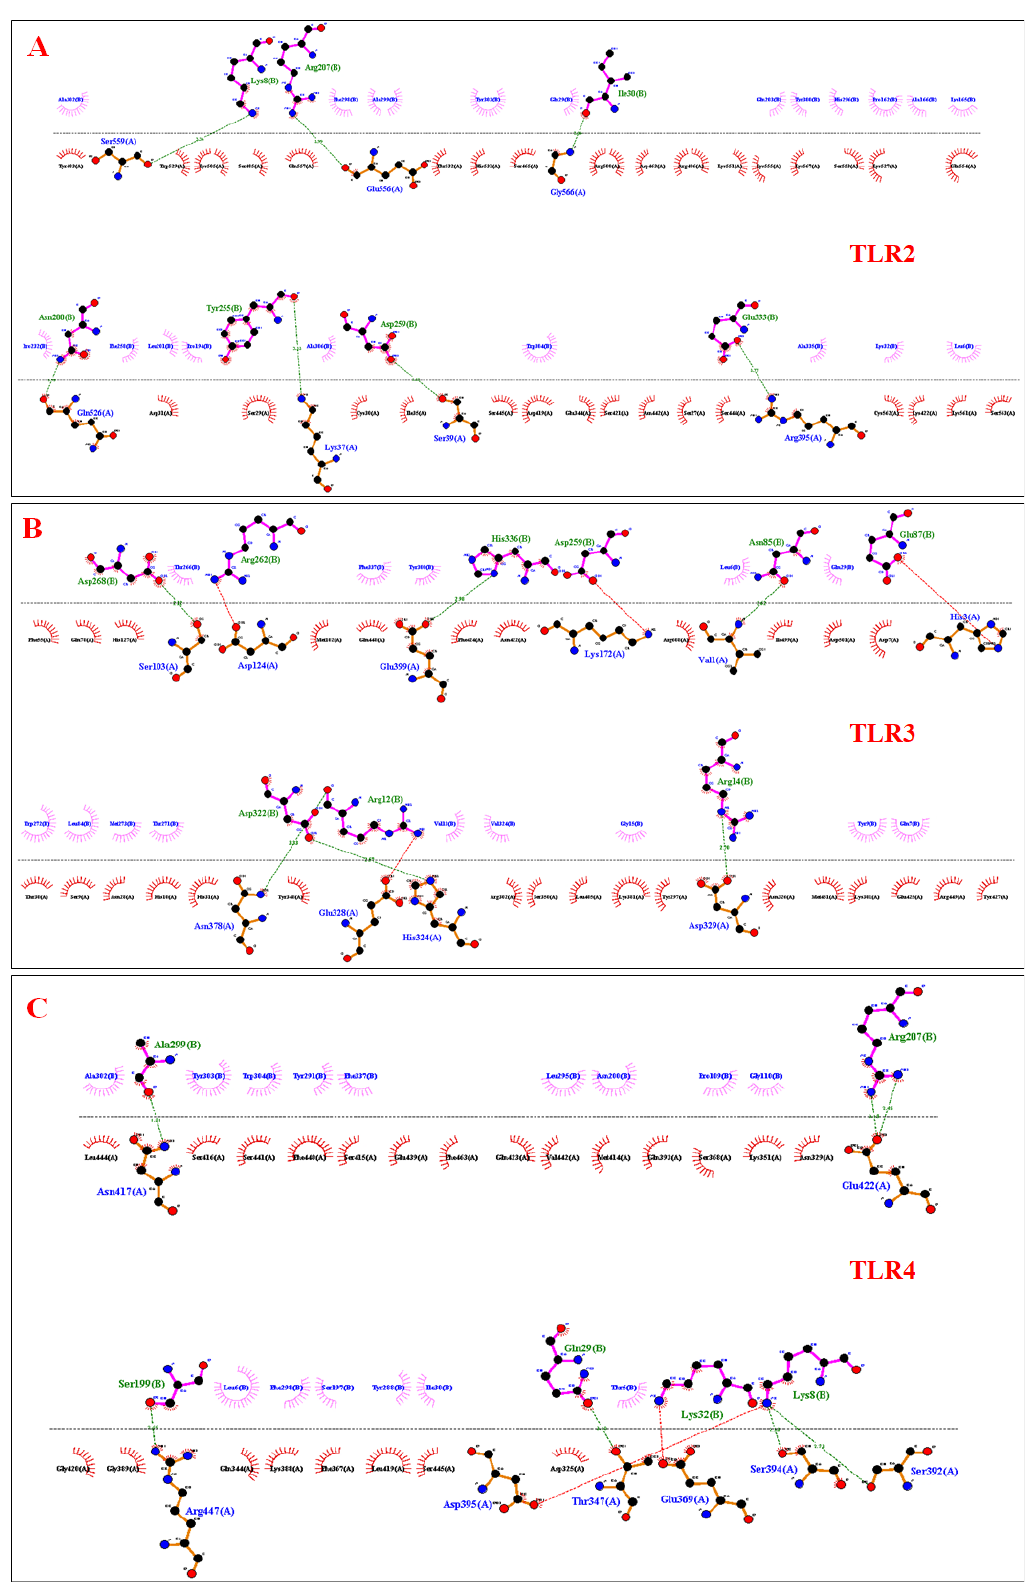
Figure 6. Intermolecular hydrogen bonds and hydrophobic interactions represented in 2D structures for TLRs and vaccine construct complex ( A ) Vaccine — TLR2 docked complex ( B ) Vaccine — TLR3 docked complex ( C ) Vaccine — TLR-4 docked complex.